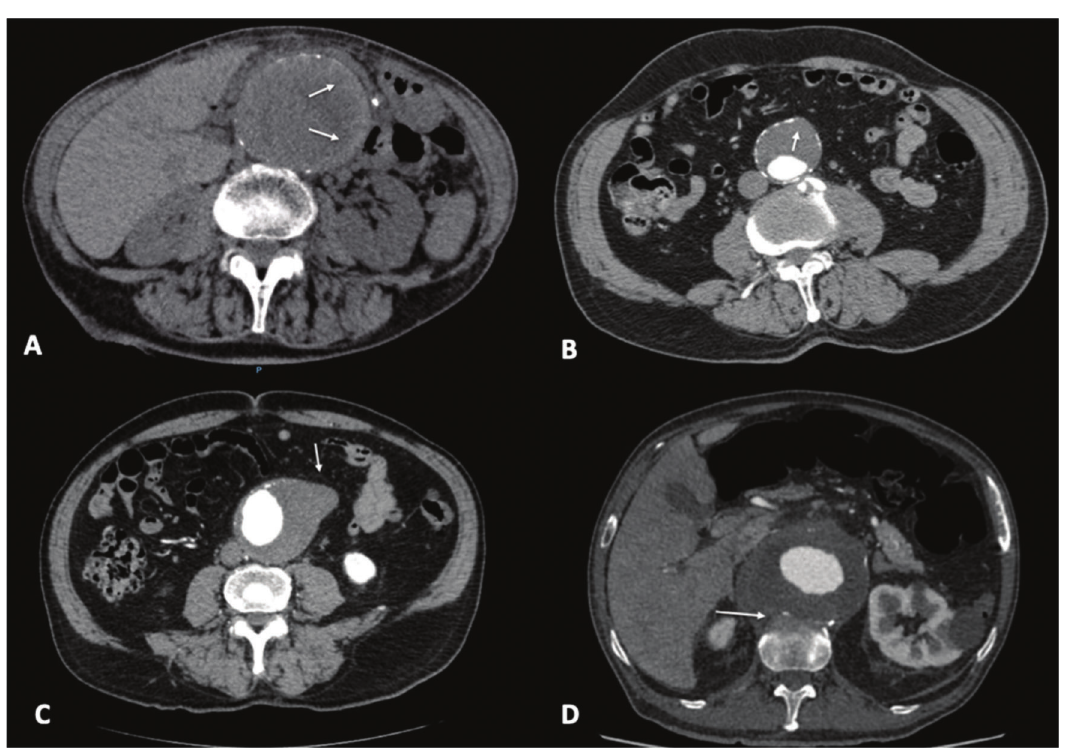
Figure 3 - Axial abdominal CT images showing infrarenal abdominal aortic aneurysms with SIR (white arrows). A: Crescent sign. B: Focal wall discontinuity of circumferential calcifications. C: Aortic bulges or blebs. D: Draped aorta